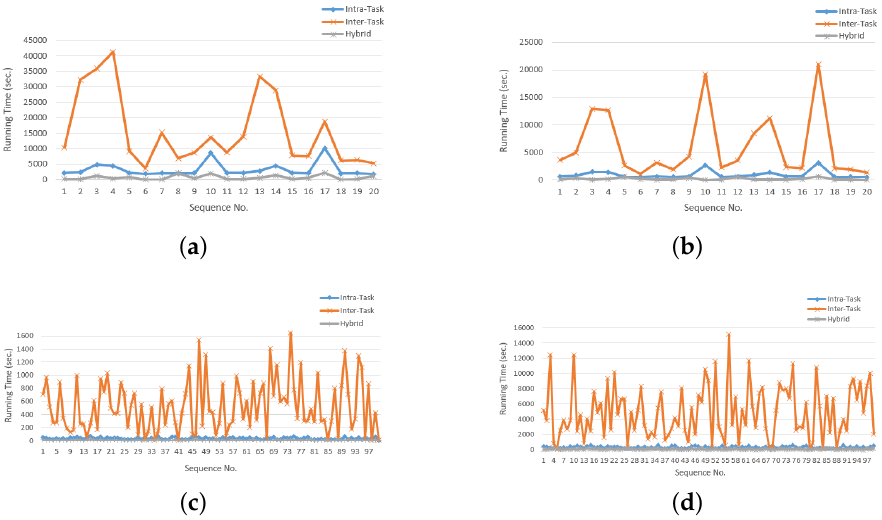
Figure 12. Comparison of execution time of proposed parallel approaches. ( a ) Comparison of execu- tion time of all three parallel approaches on GeoLife dataset with query sequence 001. ( b ) Execution time of all three parallel approaches on GeoLife dataset with query sequence 006. ( c ) Execution time of all three parallel approaches on Genome dataset with query sequence gbpln103. ( d ) Execution time of all three parallel approaches on Genome dataset with query sequence